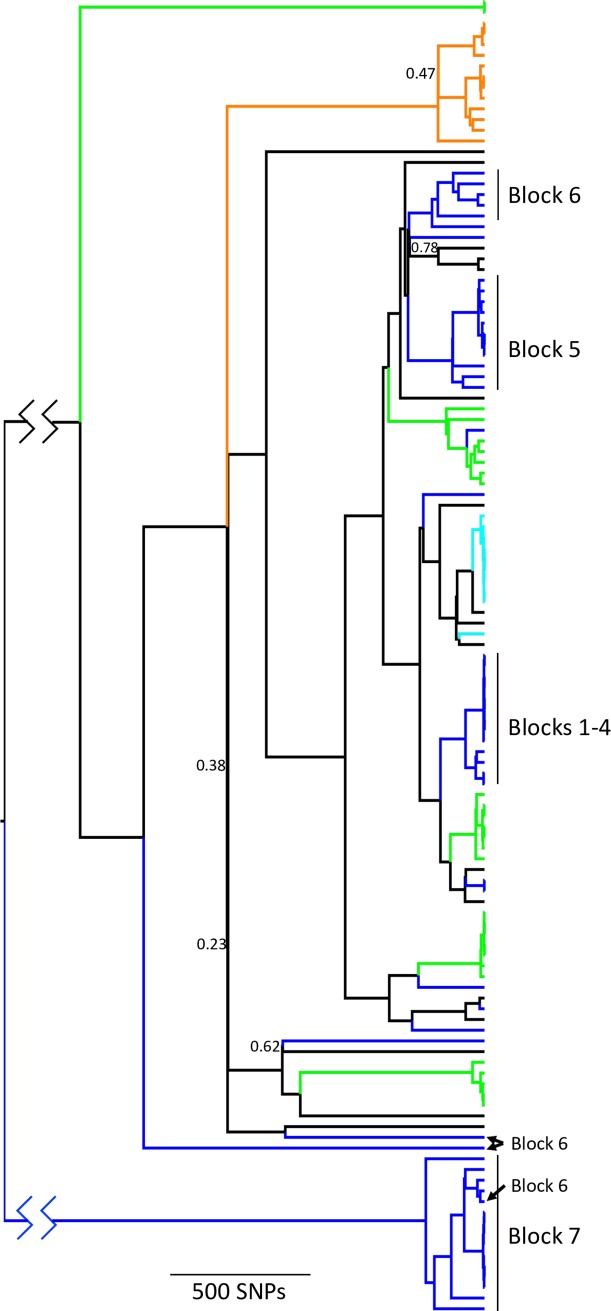
T. cruzi collected from the same block often forms a monophyletic group.The maximum clade credibility phylogeny includes all 123 T. cruzi samples collected from Arequipa with samples from Mariano Melgar labeled blue and those from La Joya labeled green. Block numbers are labeled for the 48 samples collected from Blocks 1–7 in Mariano Melgar. Black branches represent samples collected from the other districts in the Arequipa region: Bustamante, Cayma, Huanca, Miraflores, Sachaca, Tiabaya, Uchumayo, and Vitor. T. cruzi from each district, for example, Mariano Melgar and La Joya, span the phylogenetic diversity in the region suggesting that most of the genetic variation in Arequipa can be found within each single district. The T. cruzi in many blocks within Mariano Melgar were likely introduced from another district as their closest relatives were detected in other districts and not in other blocks within Mariano Melgar. Jagged lines in most basal branch indicate that the branch was shortened for visualization. Posterior probabilities less than 0.80 are labeled for basal nodes. A modifiable phylogeny containing all tip labels and posterior probabilities can be found in S1 Appendix.